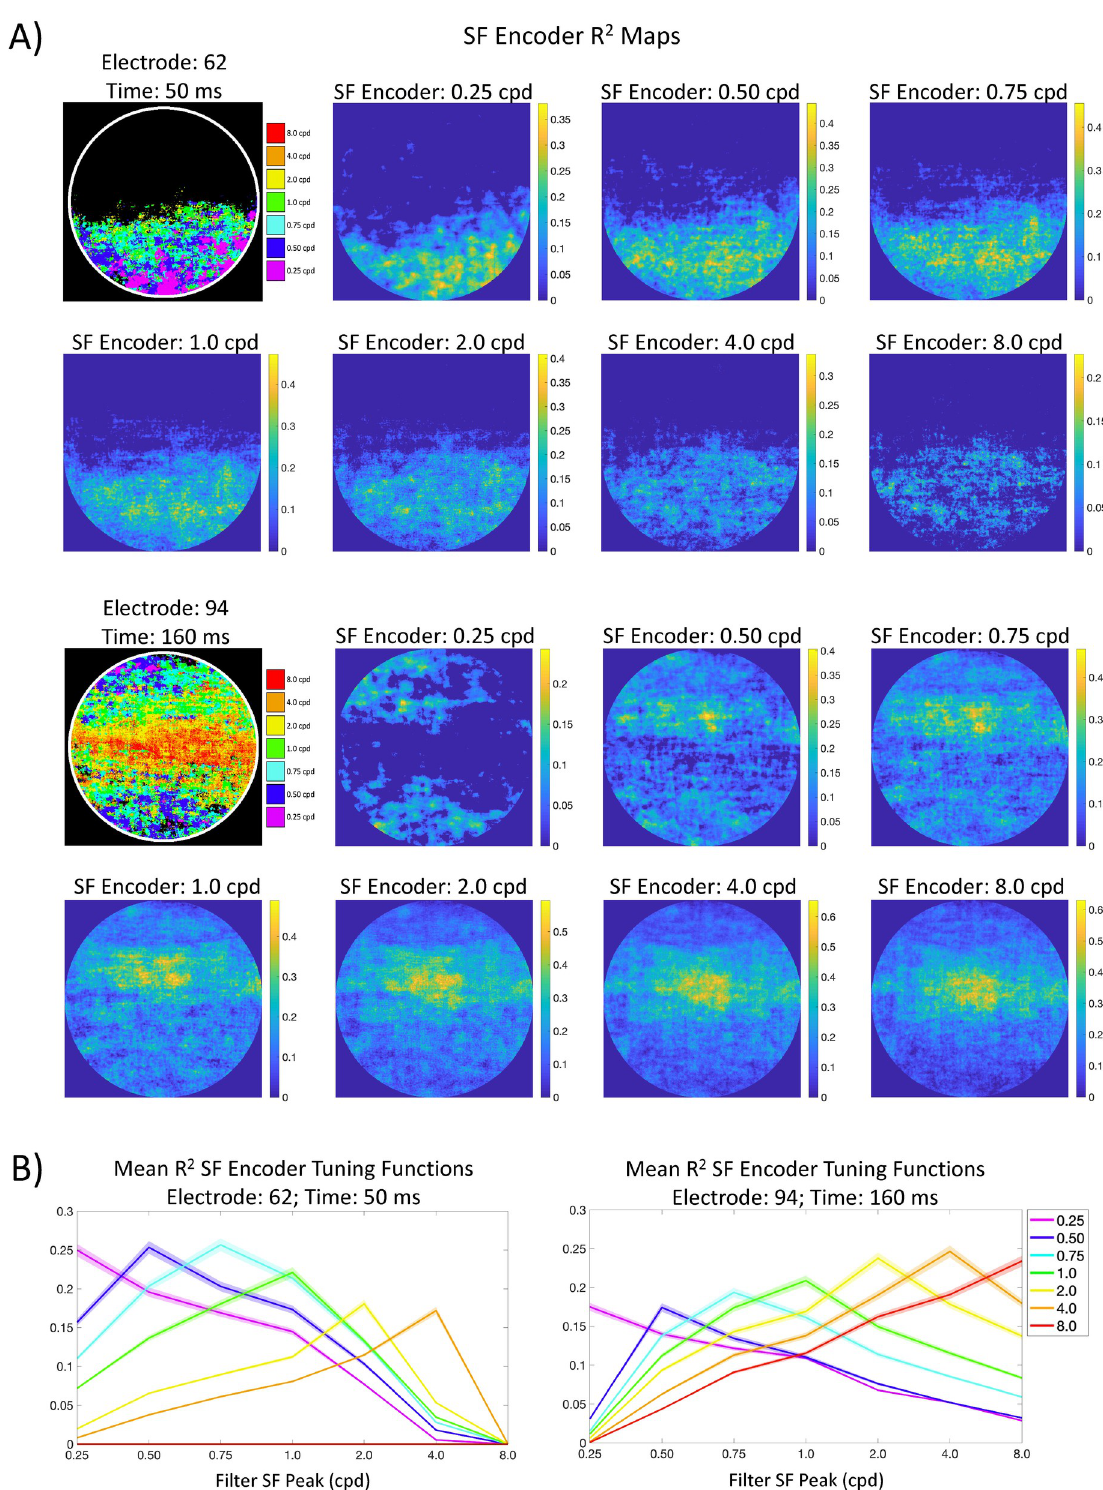
Fig 4. A) Example R 2 maps from two different electrodes and time points. The DETI maps for each example are shown in the upper left of each set of R 2 maps. Each R 2 map shows significant R 2 s at each pixel location in image space. The color bar for each map shows R 2 . B) Example encoder R 2 tuning functions for the two DETI maps shown in (A), averaged over all instances of each encoder’s tag in the DETI maps (y-axis is averaged R 2 , x-axis is encoder peak SF). The shaded region of each trace shows the 95% confidence interval over all instances of pixels for each